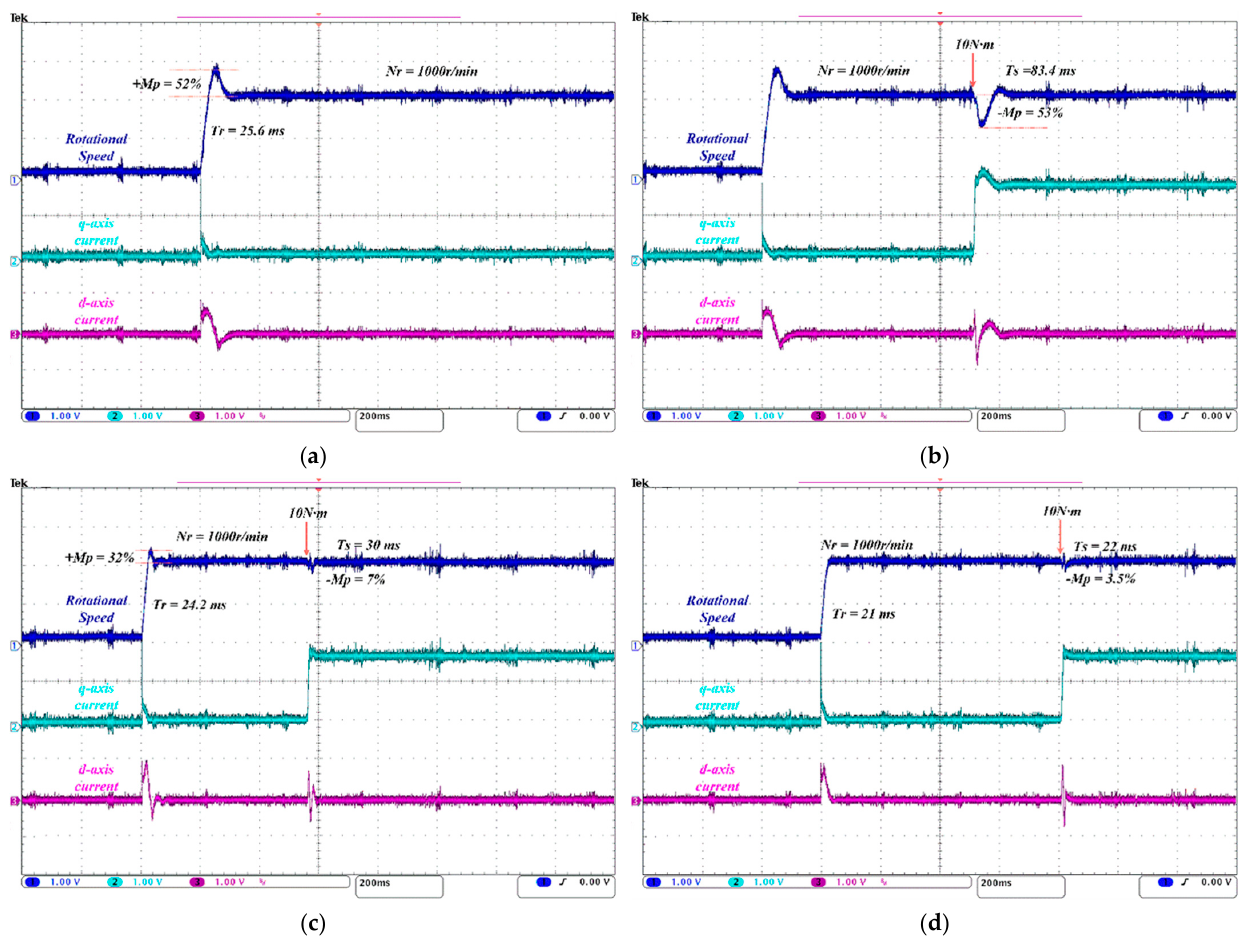
Figure 6. PMSM stator three phase current waveforms. ( a , b ) I–SMC, ( c ) SMC, and ( d ) NOD–SMC.